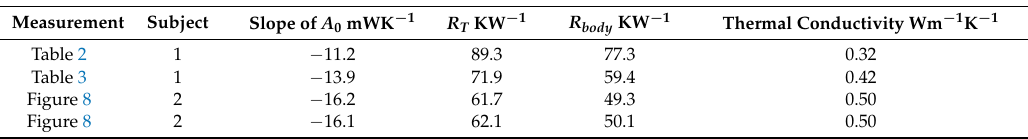
Table 4. Thermal resistance and thermal conductivity of the human body with subject 1 being a 23-year-old male and subject 2 being a 59-year-old male.